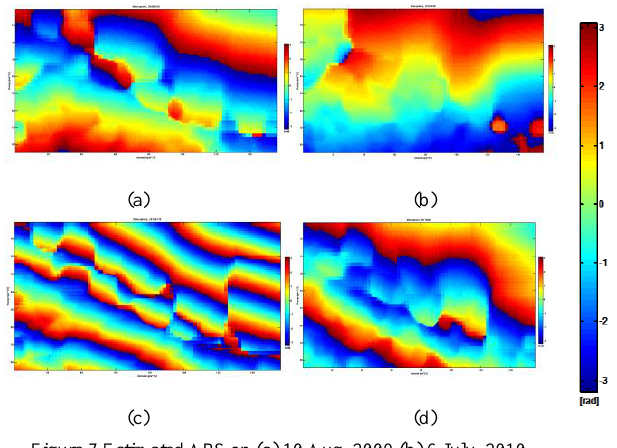
Figure 7 Estimated APS on (a) 10 Aug, 2009 (b) 6 July, 2010 (c) 28 July, 2010 (d) 6 Aug,